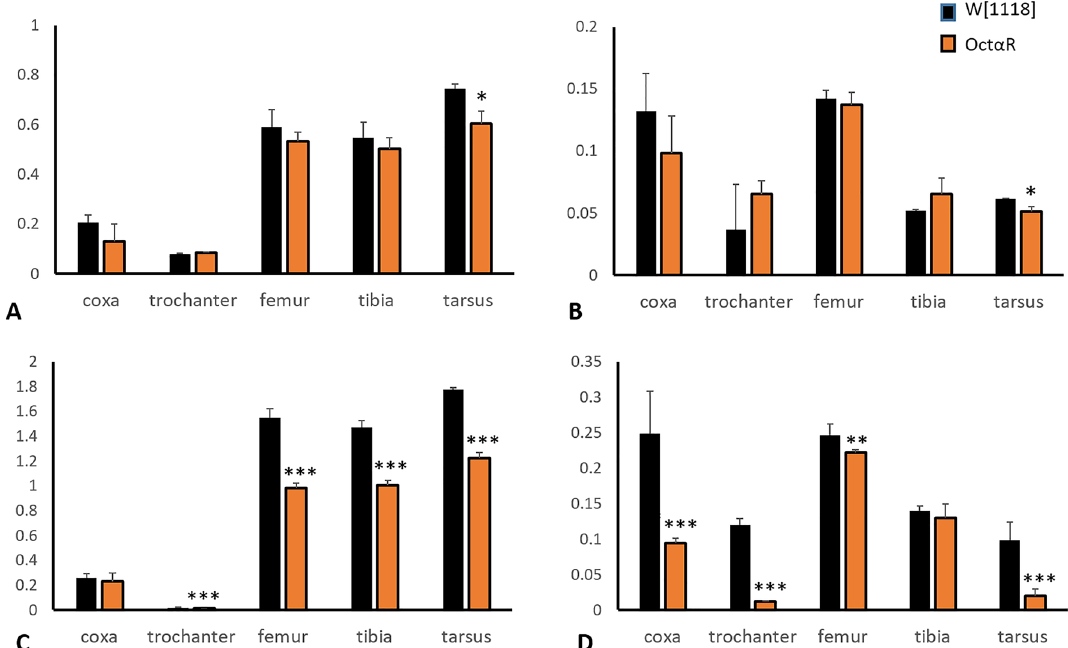
Figure 7. The effect of OctαR knock out on the length and width of fore and hind legs’ parts as compared to those of w 1118 . Mean ± SD; N = 10; * P ˂ 0.05, ** P ˂ 0.01, *** P ˂